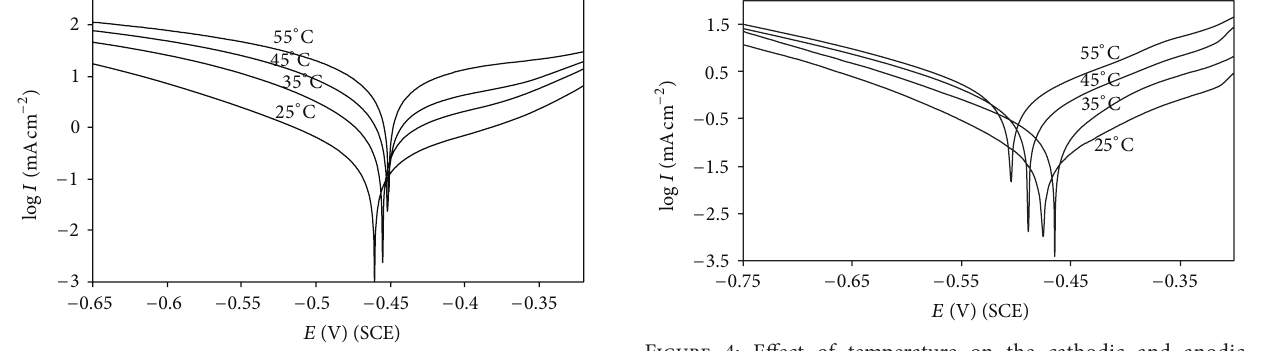
Figure 2: Effect of temperature on the cathodic and anodic responses for C38 steel in 1M HCl.